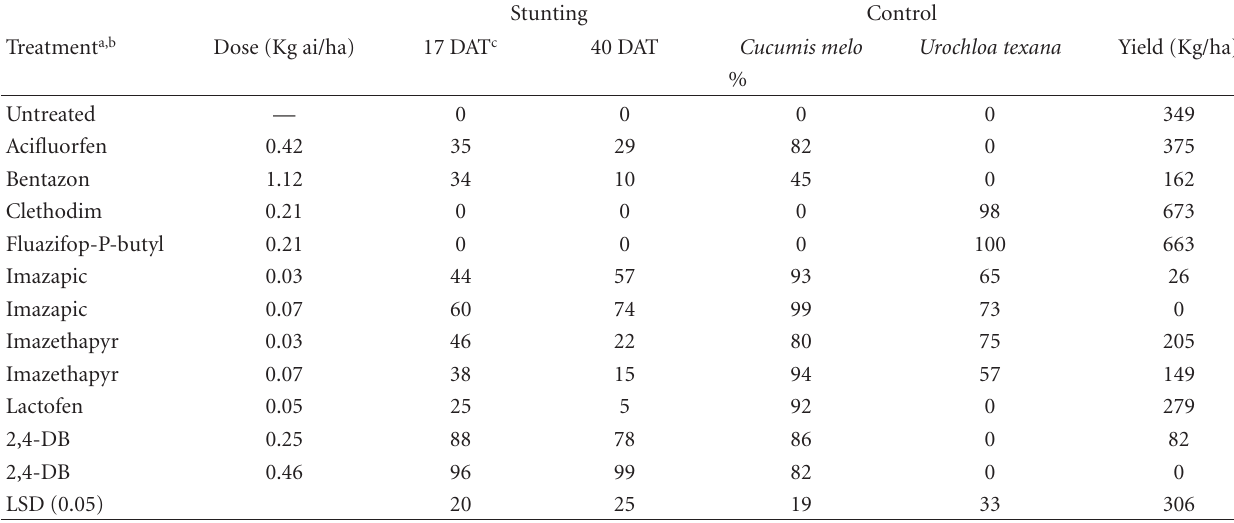
Table 1: Castor response and weed control to postemergence herbicides in south Texas,